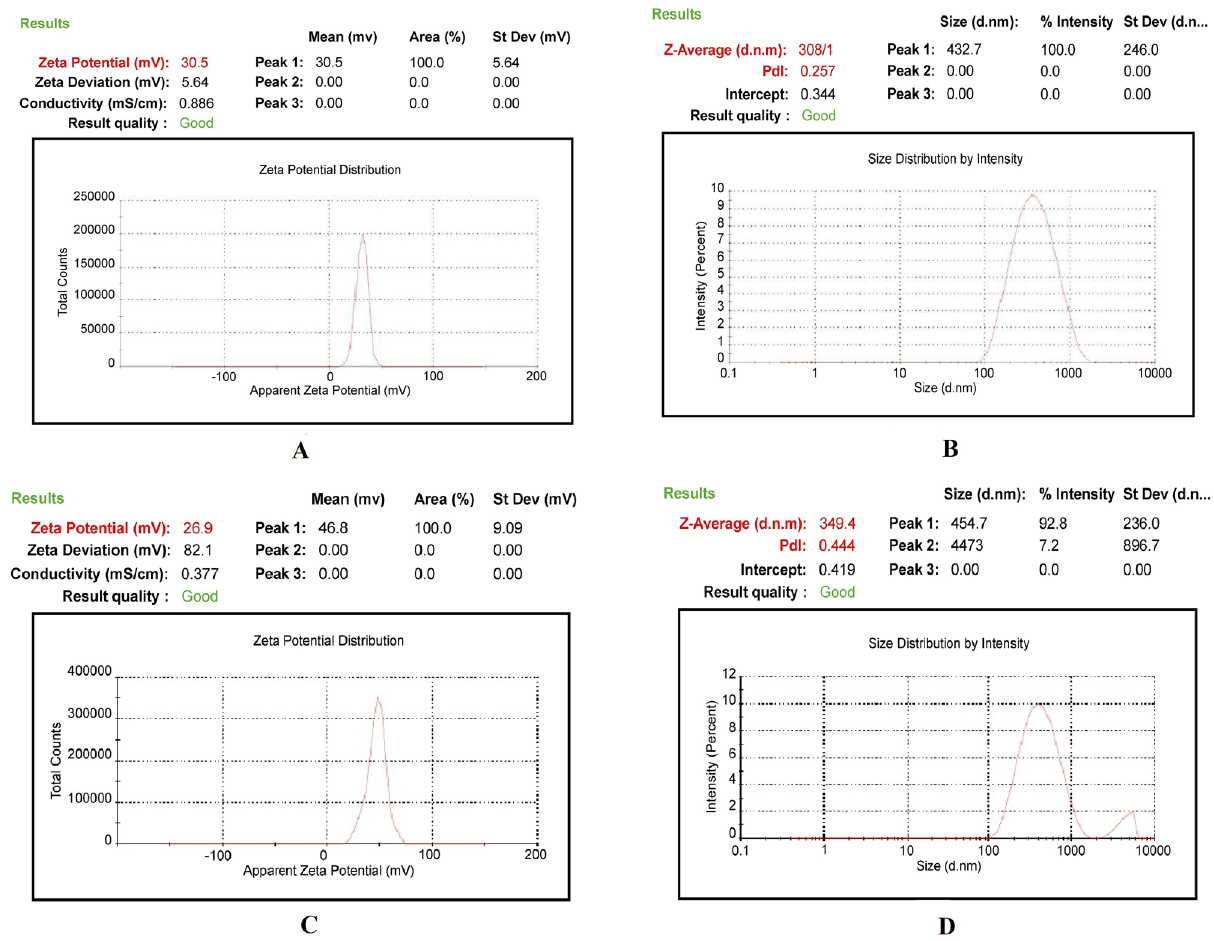
Figure 3. Physical characterization of nanoparticles. ( A ) Zetapotential analysis of injectable CCNP colloidal solution. ( B ) Size distribution analysis of injectable CCNP colloidal solution. ( C ) Zetapotential analysis of